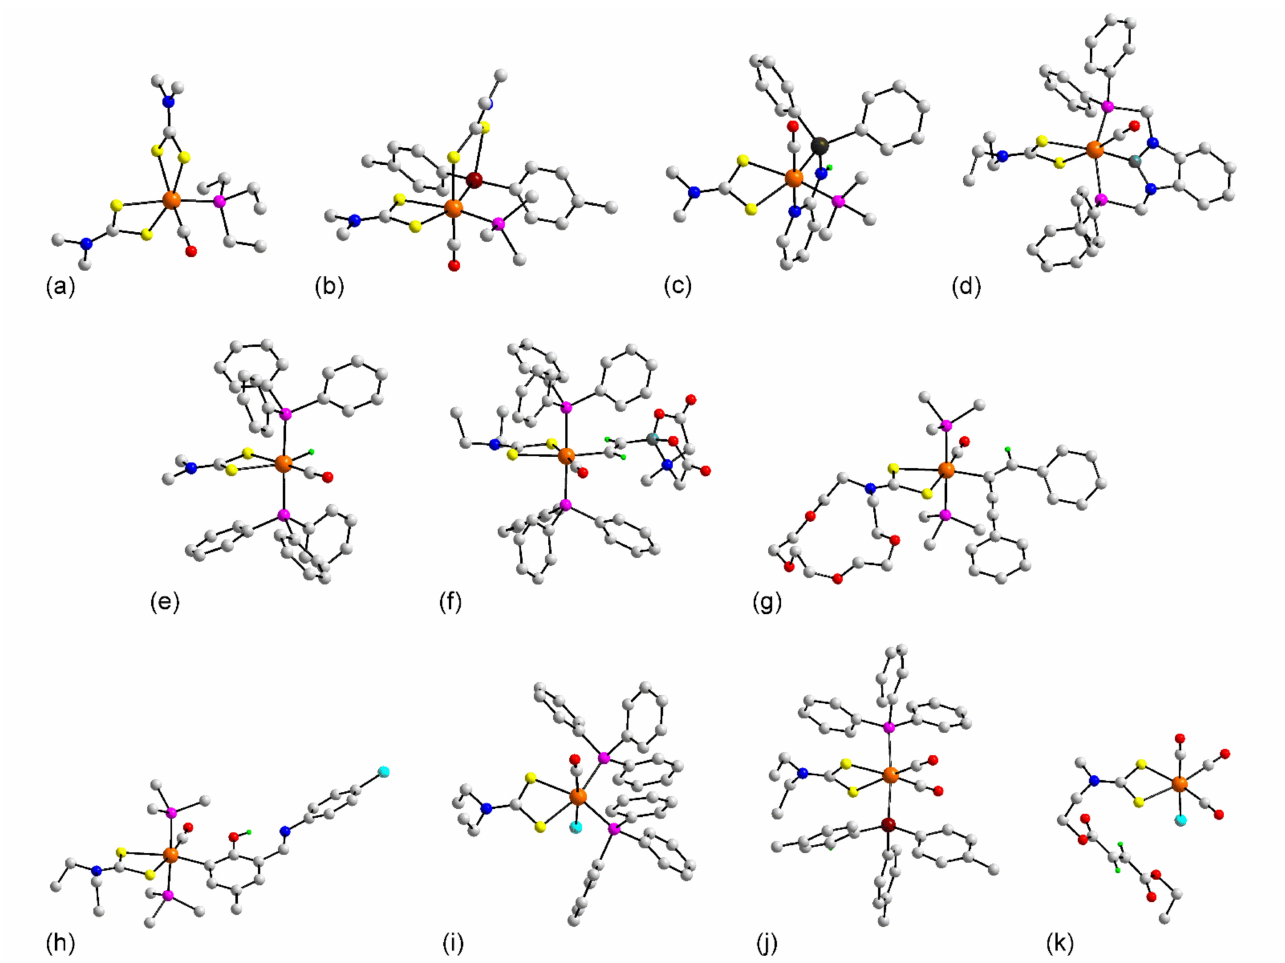
Figure 4. Molecular structures of ruthenium complexes: ( a ) (PEt 3 )Ru( L 8 ) 2 (CO) ( 22 ), ( b ) (PPh 3 )Ru{Ge(p-tolyl) 2 }( L 8 ) 2 (CO) in the crystal of 23 , ( c ) (PPh 3 )Ru( κ 2 (Si,N)-SiPh 2 NHC 5 H 4 N)( L 8 )(CO) ( 24 ), ( d ) Ru(B(NCH 2 PPh 2 ) 2 C 6 H 4 )( L 24 )(CO) ( 27 ), ( e ) (PPh 3 ) 2 Ru(H)( L 8 )(CO) ( 29 ), ( f ) (PPh 3 ) 2 Ru(C(H)=C(H)BMIDA)( L 24 )(CO) in 33 , ( g ) (PPh 3 ) 2 Ru(C(C ≡ C(Ph)=C(H)Ph)( L 84 ) (CO) ( 38 ), ( h ) (PPh 3 ) 2 Ru(X)( L 24 )(CO) ( 43 ), ( i ) (PPh 3 ) 2 Ru( L 24 )(CO)Cl in 44 , ( j ) (PPh 3 )Ru(Ge(p-tolyl) 3 )( L 24 )(CO) 2 ( 48 ), and ( k ) Ru( L 22 )(CO) 3 Cl ( 49 ). In ( b , c , g , h ), only the ispo-C atoms of the phosphane bound phenyl rings are shown for clarity. Additional color code: silicon, dark green; boron,